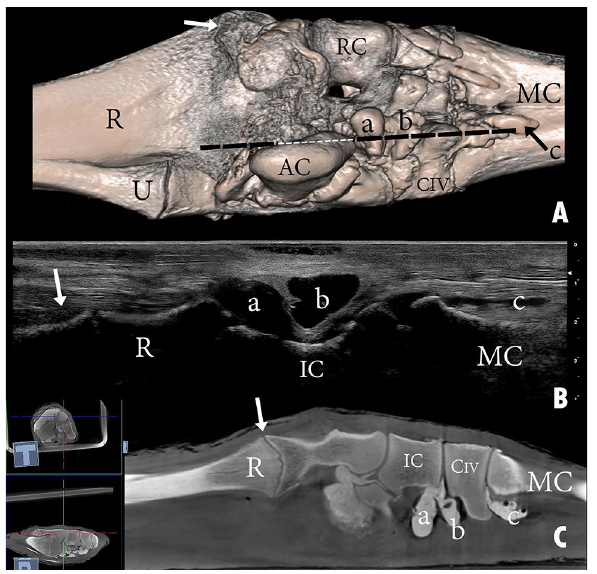
Figure 14. Palmar view of a left carpal joint showing ( A ) three-dimensional reconstruction of the carpal joint (the black dotted line indicates the palmolateral placement of the ultrasound probe); ( B ) longitudinal composed ultrasound image of the carpal joint; ( C ) sagittal plane computerized tomography image. R, the distal end of the radius; U, the distal end of the ulna; AC, accessory carpal bone; RC, radiocarpal bone; IC, intermediate carpal bone; CIV, carpal bone IV; MC, metacarpal bone; a and b, palmar pouch of the intercarpal joint; c, lateral pouch of the carpometacarpal joint. The white arrow indicates the epiphysial